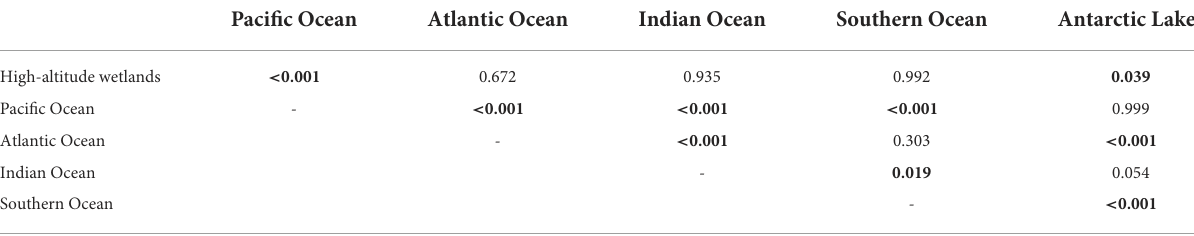
TABLE 2 Tukey test comparison of VPR values of the South hemisphere ecosystems.